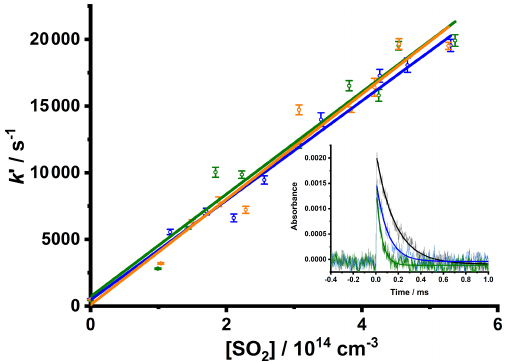
= 5 (cid:16) (cid:17) 3 . 70 + 0 . 45 − 0 . 40